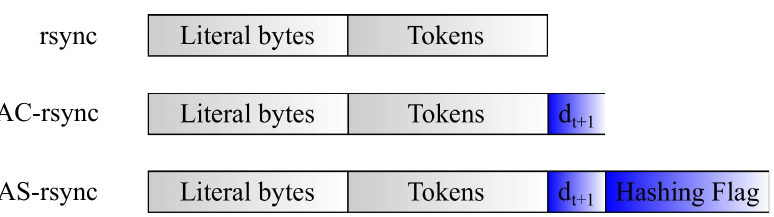
Figure 5. Delta structure in original rsync , AC- rdiff and AH- rdiff